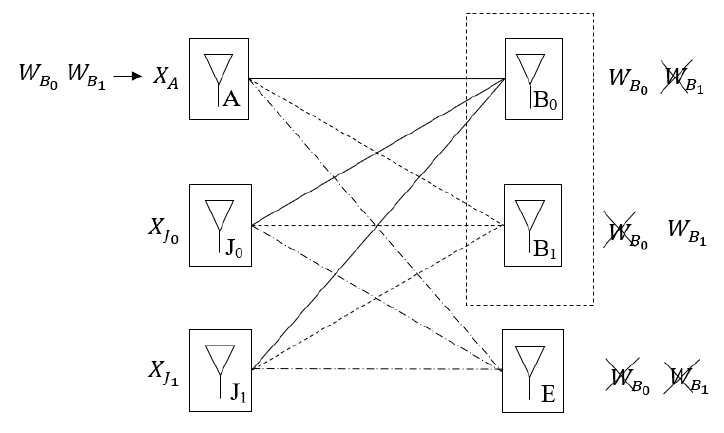
Figure 1. System Figure 1. System model.